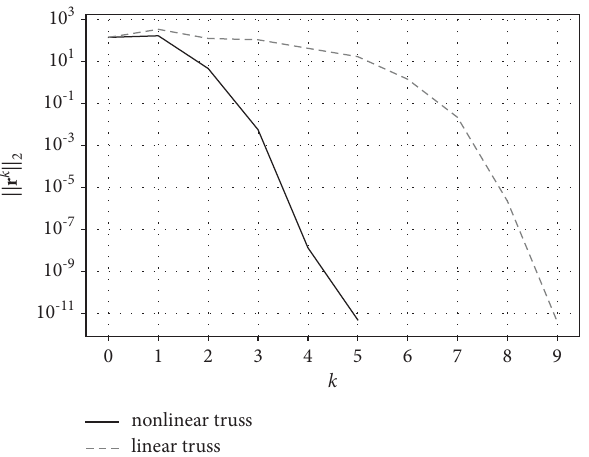
Figure 8: Convergence of the 2D framework bridge